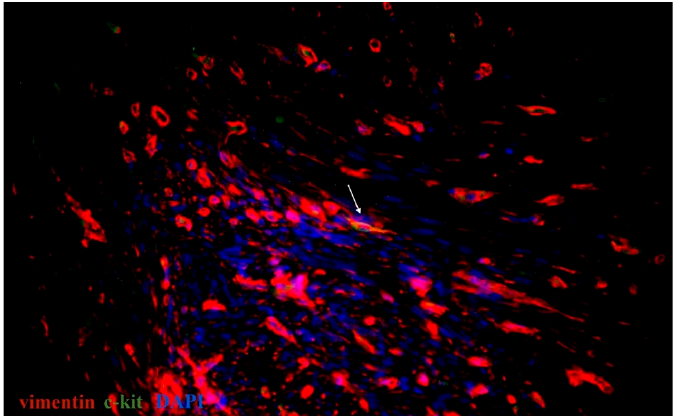
Figure 4. Double immunolabelling of tissue sample from uterine myoma stained for vimentin (red, Alexa Fluor 594) and c-kit (green, Alexa Fluor 488). Nuclei stained by DAPI. Doubly immunopositive cell with oval-shaped body and cellular prolongation identified as a telocyte (marked by an arrow). Total magnification: ×